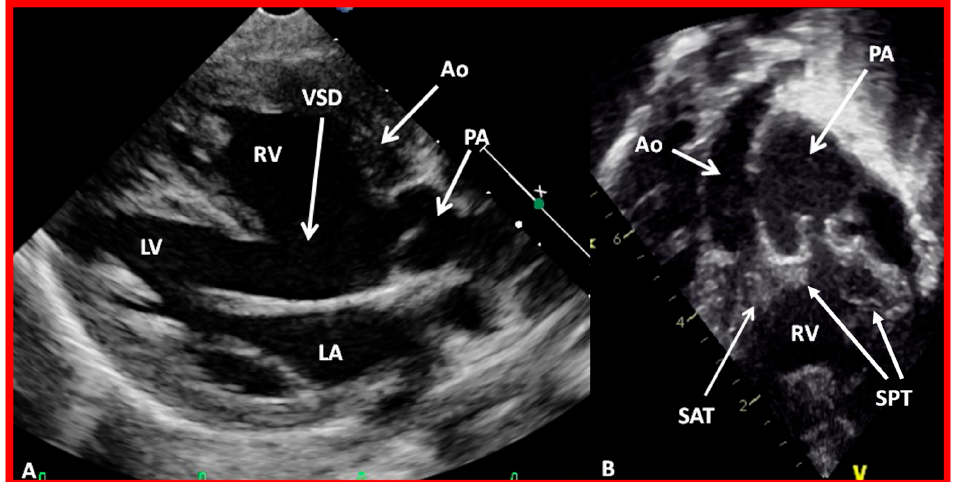
Figure 49. Echo images from the parasternal long axis ( A ) and subcostal ( B ) projections of a child with Taussig-Bing type of double-outlet right ventricle (with transposition of great vessels) illustrating that both the pulmonary artery (PA) and the aorta (Ao) arise from the right ventricle (RV). A large ventricular septal defect (VSD) and subaortic (SAT) and subpulmonary (SPT) tissues are also shown. The vessel marked PA was further traced and was demonstrated to divide into right and left PAs. Left atrium (LA) and left ventricle (LV) are labeled. Modified from reference [43].